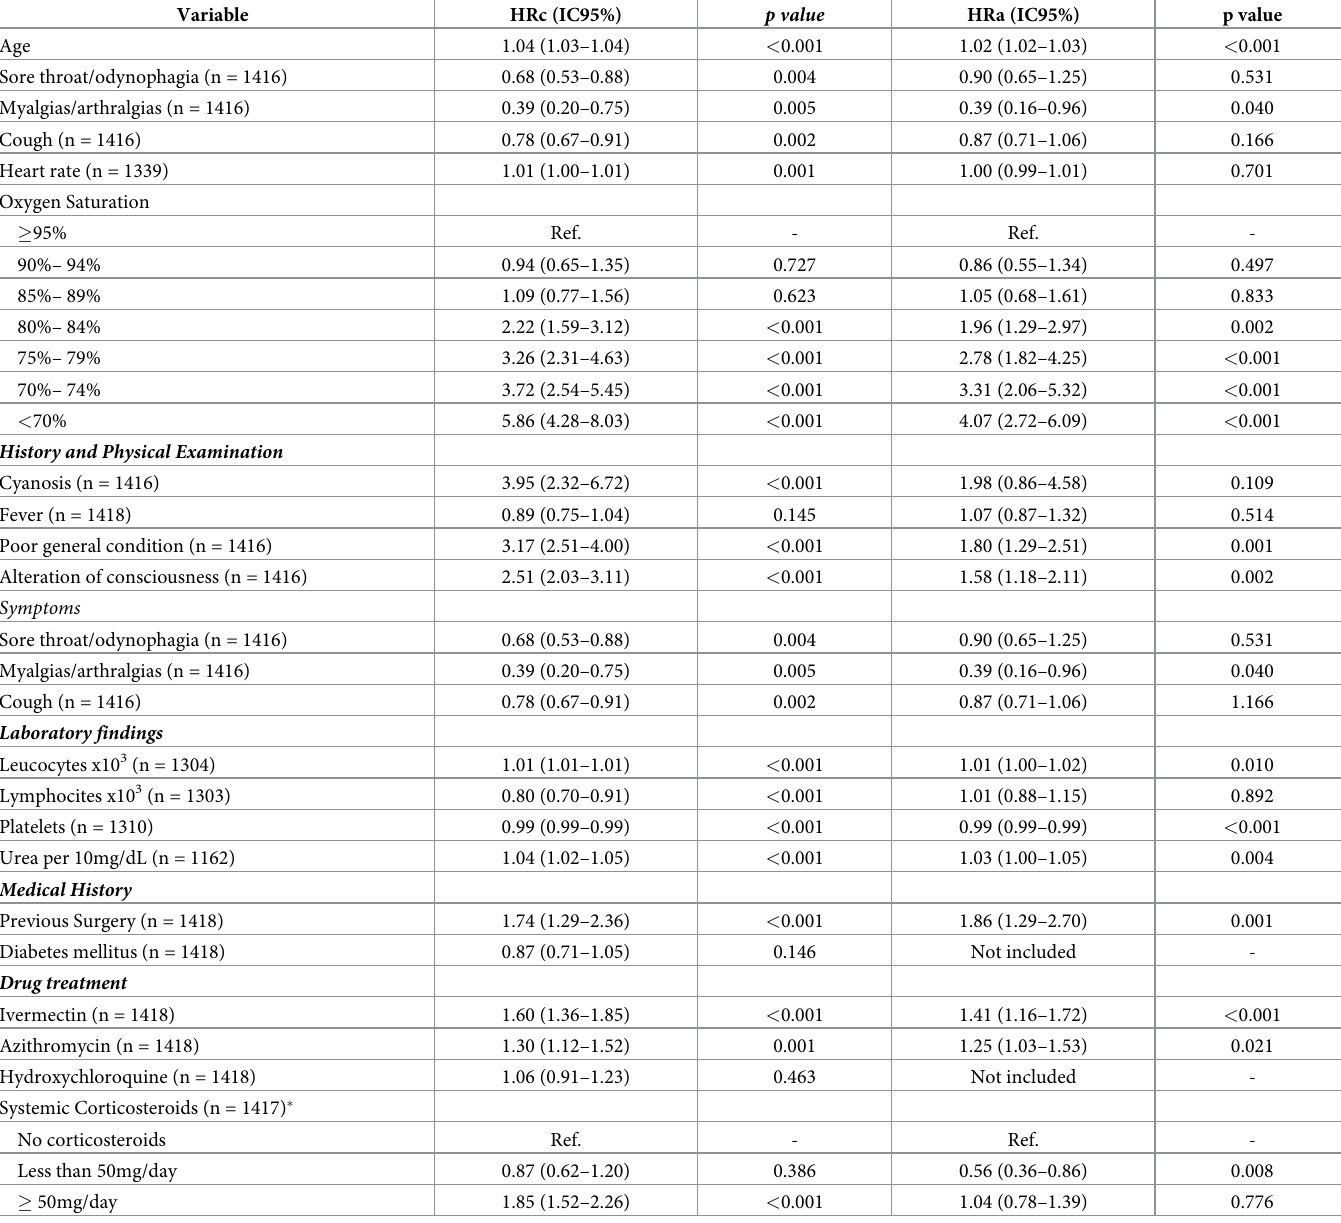
Table 6. Mortality risk factors in COVID-19 patients hospitalized at Hospital Nacional Hipo´lito Unanue from April to August 2020. Results from multivariate analysis.